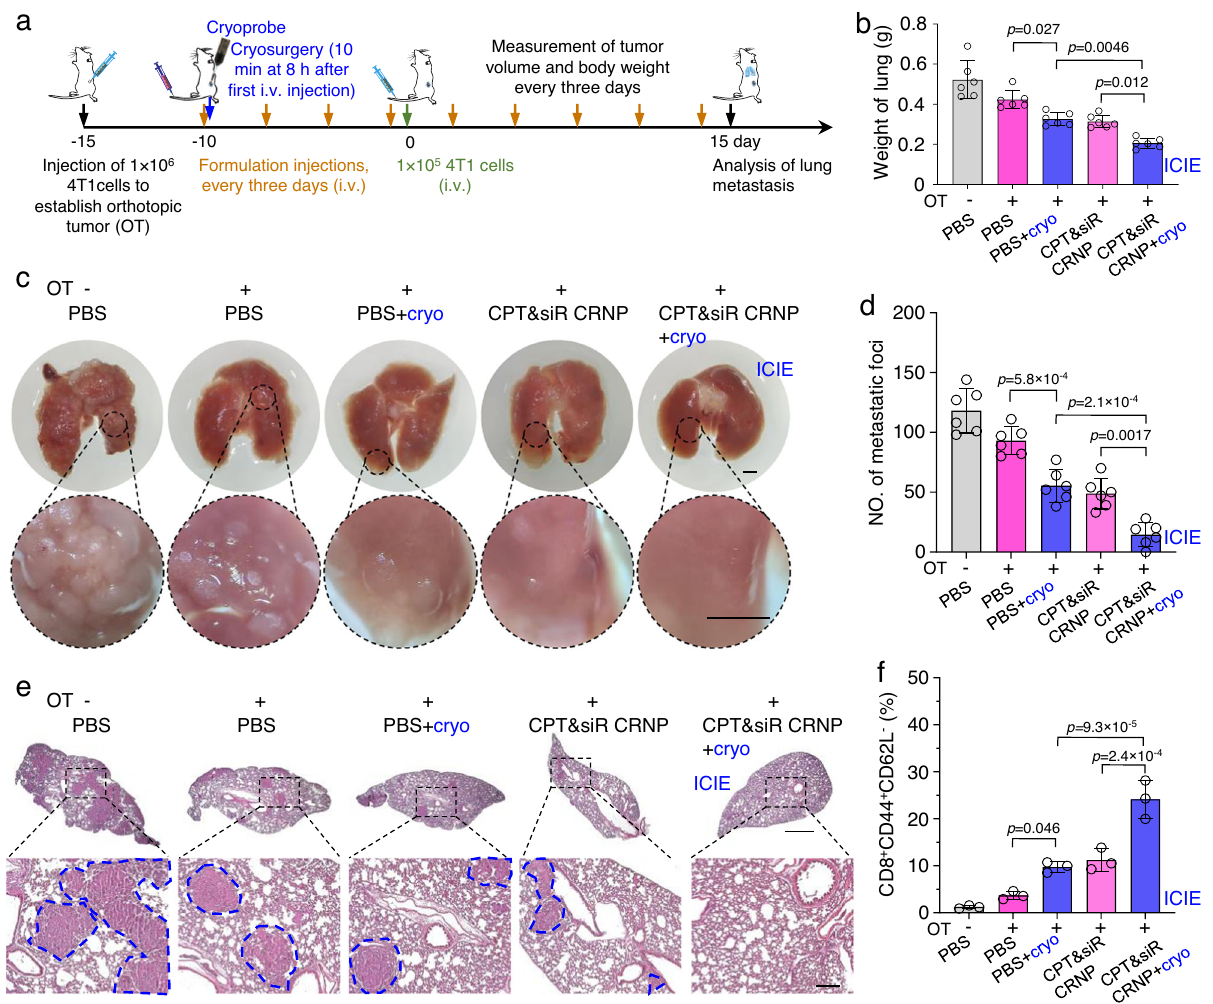
Fig. 8 | ICIE generates long-term antitumor memory immune response and inhibits metastasis in the lung. a A schematic illustration of the in vivo experi- mental design. Mice received an intravenous injection of various formulations every3days.Cryosurgerywasperformedontheorthotopictumor(OT)at8hafter the fi rst injection of the various formulations. The lung metastasis model was induced by intravenous injection of 4T1 cancer cells on day 10 after the fi rst injectionofthedifferentformulations. b Weightoflungscollectedfrommiceatthe end of the study, suggesting inhibition of lung metastasis by ICIE ( n =6 mice). c Representative photographs of lung tissues isolated at the end of the study, showing inhibition of lung metastasis by the ICIE treatment. Scale bar: 1mm. d Quanti fi cation of lung metastasis nodes per mouse from mice at the end of the